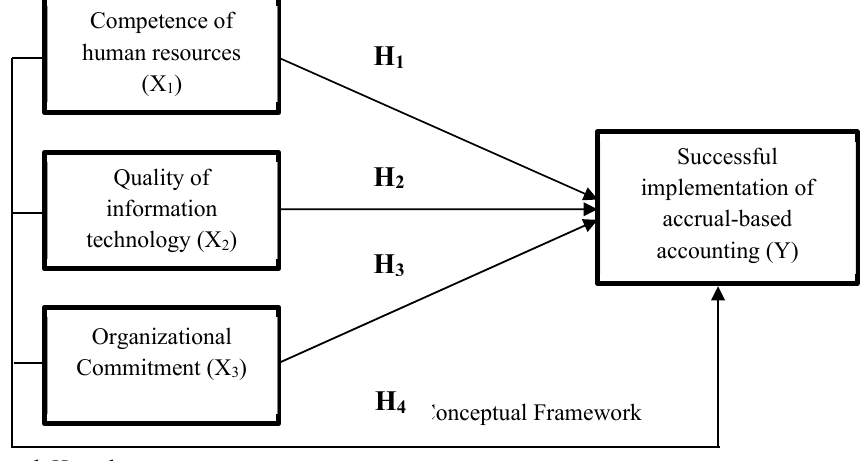
Fig. 1. Conceptual